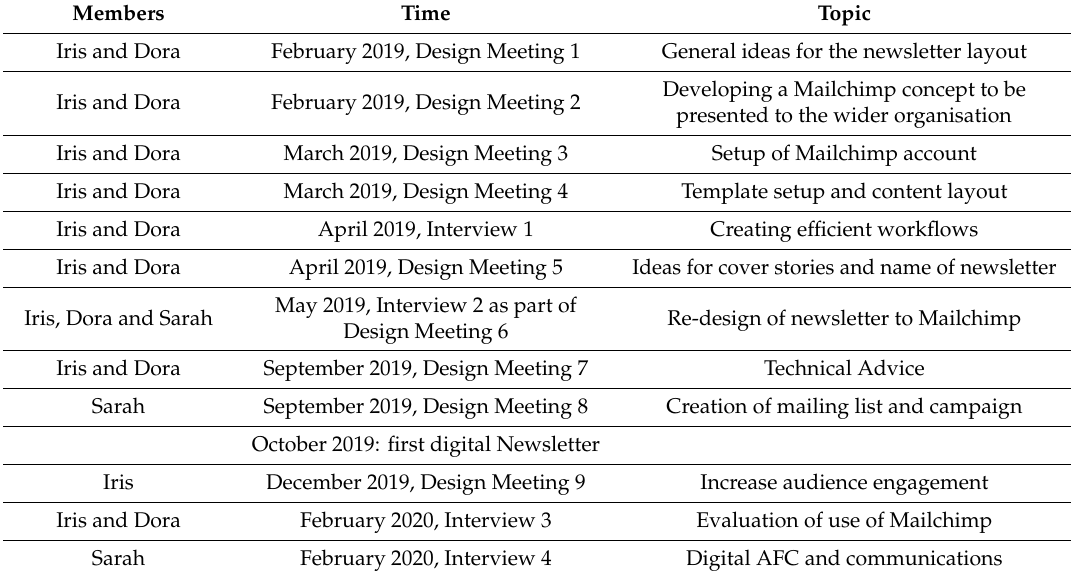
Table 1. Interviews and design meetings